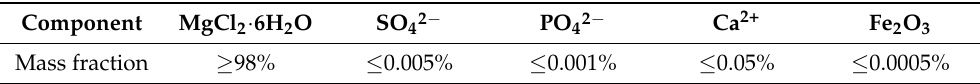
Table 2. Composition of MgCl 2 · 6H 2 O.